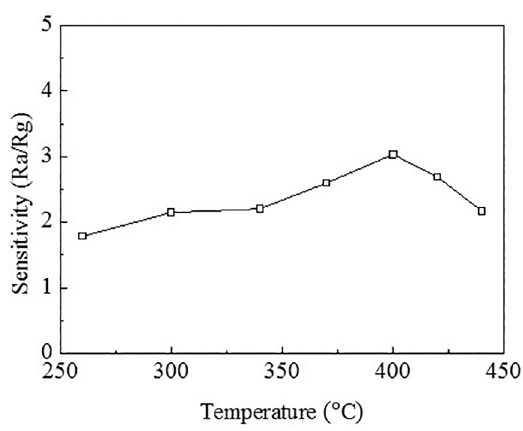
Figure 3: Sensitivity of the PbS sensor at different operating temperatures